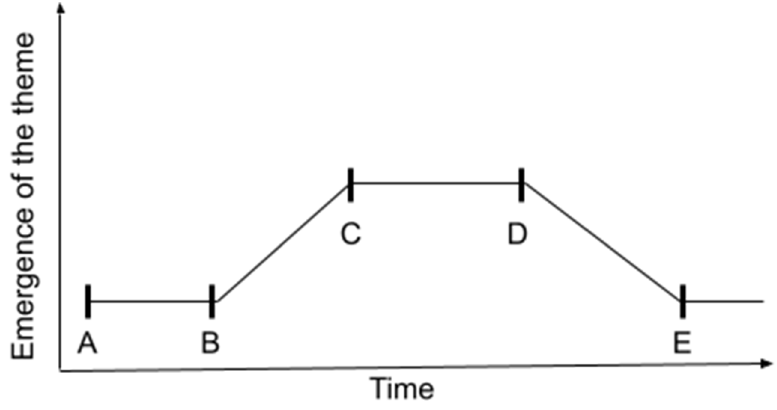
Figure 2. Timeframe for agenda ‐ setting effects. Adapted from [13].